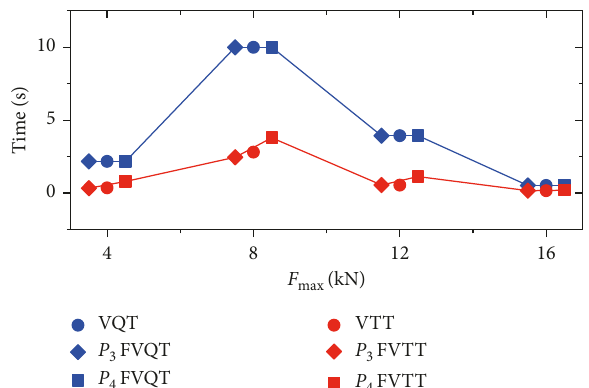
Figure 15: Vibration quit time (VQT) and vibration total time (VTT) based on an analysis of the velocity and impact force with different F